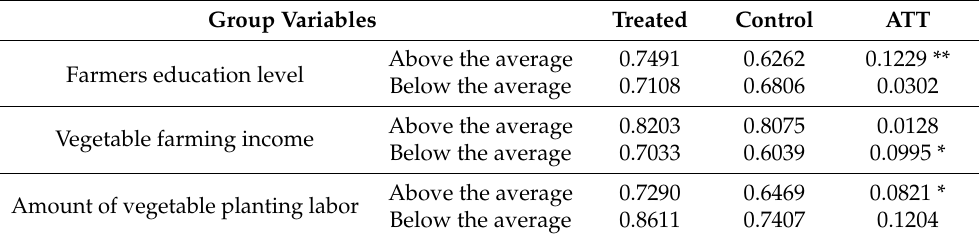
Table 5. Analysis results of the impact of Internet use on farmers’ organic fertilizer application behavior with different characteristics. Group Variables Treated Control ATT Above the average Farmers education level Below the average 0.7108 Above the average 0.8203 Vegetable farming income Below the average Above the average Amount of vegetable planting labor Below the average